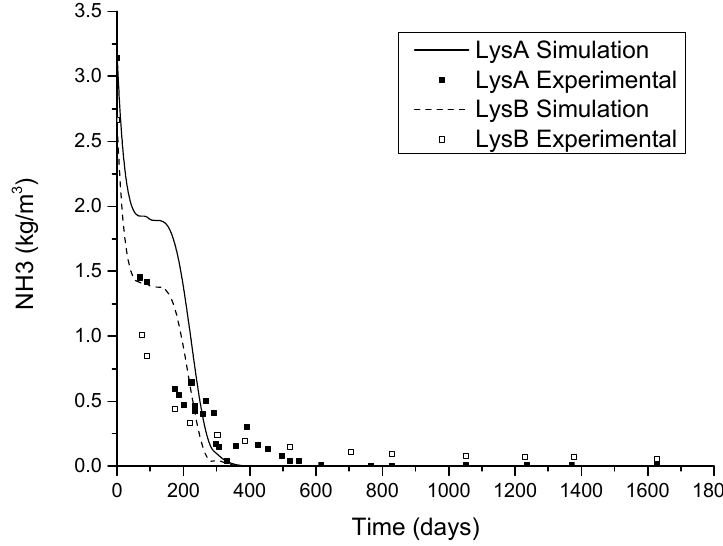
Figure 7. Time profiles of SDC degradation (experimental data cited in [37]).